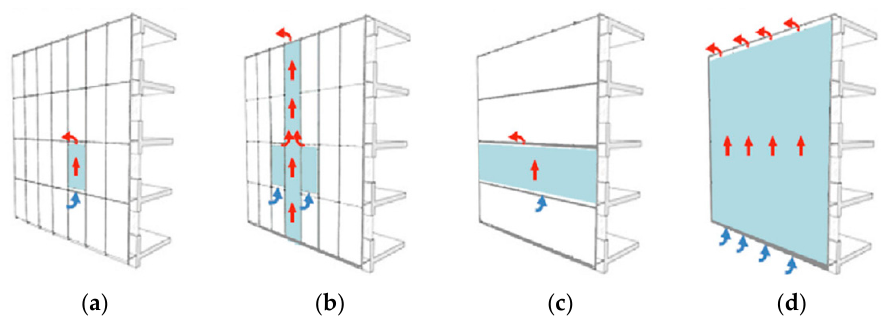
Figure 10. Classification of the DSF according to internal geometry: ( a ) box; ( b ) shaft-box; ( c ) corridor; ( d ) multi-storey (data from ref. [107–112]) .